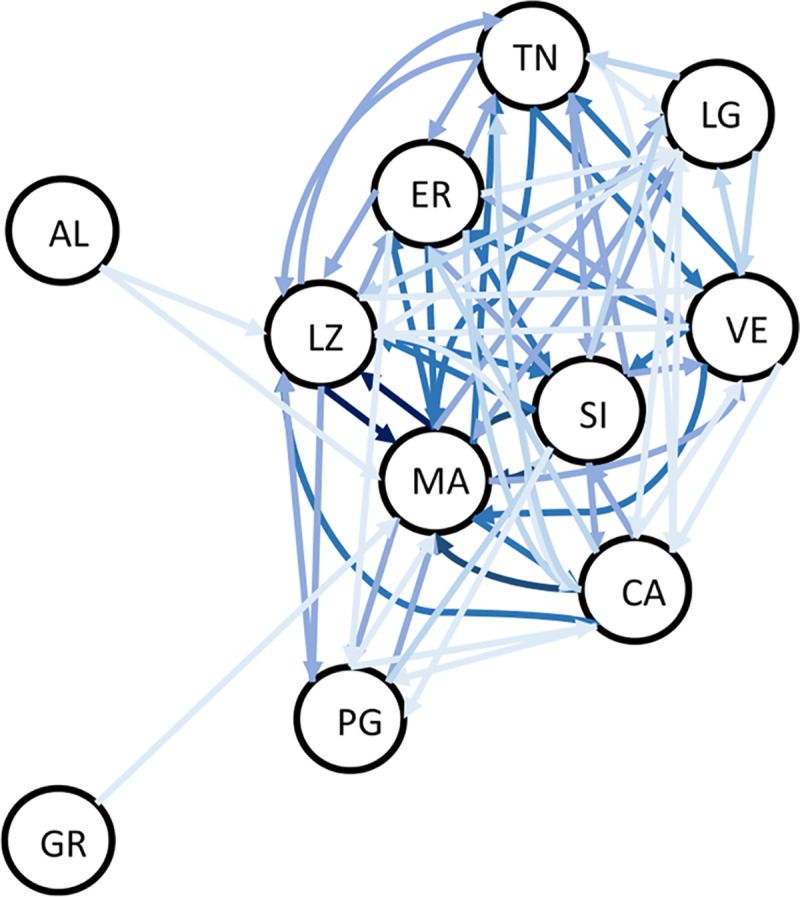
Relative migration network for the 2016-LD-filtered dataset (N SNPs = 55,199; N Inds = 77) obtained using the Nm [104] based estimate in the R-package divMigrate.Only migration rates>0.5 are represented, arrows indicate the direction of gene flow and arrow shading is relative to migration strength with darker shades representing higher values of relative migration. Populations are encoded as in Table 1.